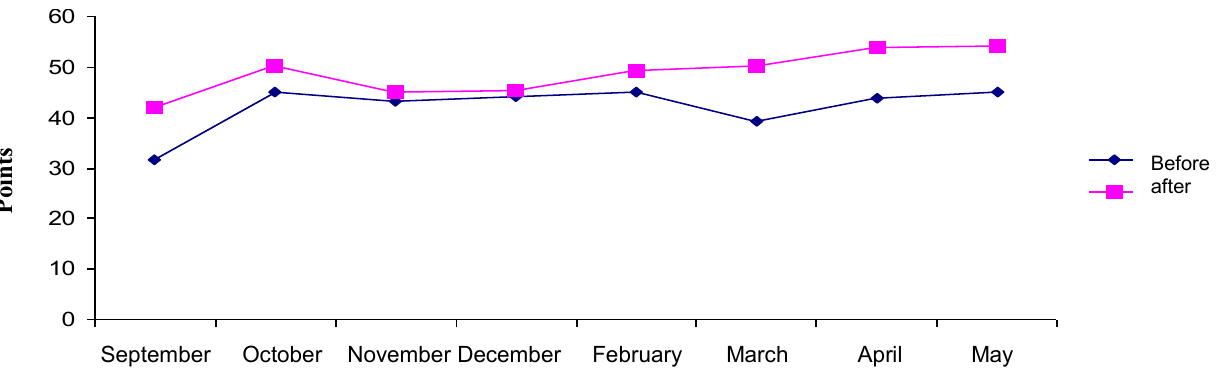
Fig.2. Dynamics of EG students’ health in the process of experimental